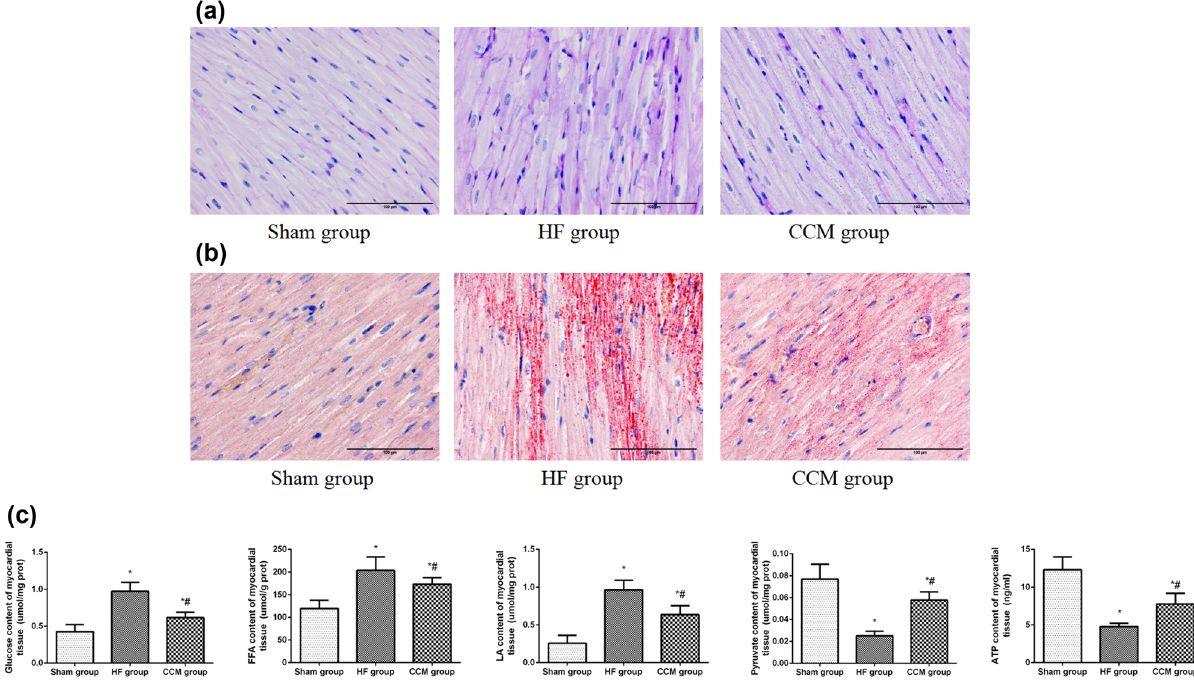
Figure 3: CCMtreatmentimprovestheutilizationofenergysubstrateandincreasedtheproductionofATP. ( a ) PASstainingofcardiactissues ( 400 × magni fi cation ) . ( b ) Oil Red O staining of cardiac tissues ( 400 × magni fi cation ) . ( c ) Detection of myocardium contents of ATP, glucose, FFA, lactic acid, and pyruvate. Data are expressed as mean values ± SD ( * P < 0.05 compared with the sham group; # P < 0.05 compared with HF group )